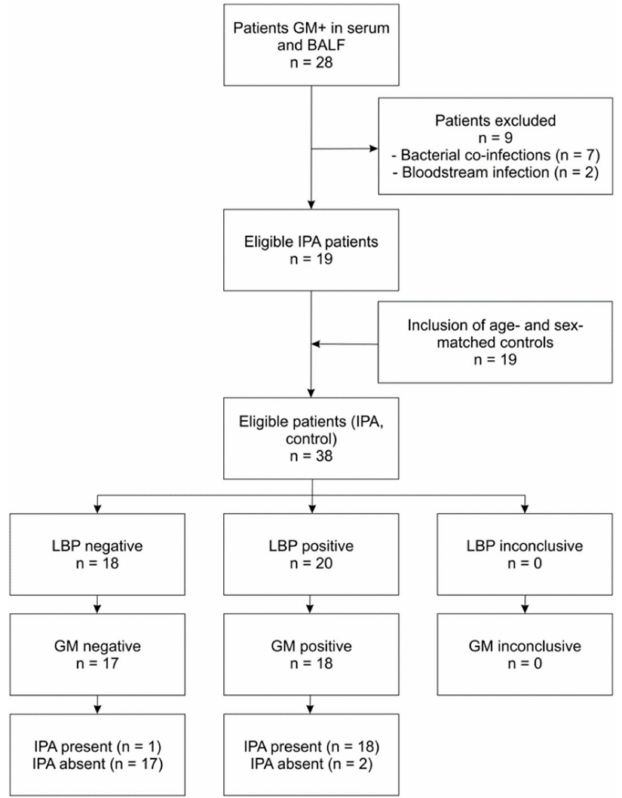
Figure 1. Flowchart indicating selection of patients and performance. The chart is exemplified for LBP in BALF as the index test, and GM in BALF as the reference test. The test positivity cut-o ff point of 18.9 pg / mL for LBP was determined according to the results of the ROC curve analysis depicted in Figure 2. Compared to GM, LBP displayed a sensitivity of 94.7%, a specificity of 84.2%, a positive predictive value (PPV) of 0.90 and a negative predictive value (NPV) of 0.94 in the selected patient group.